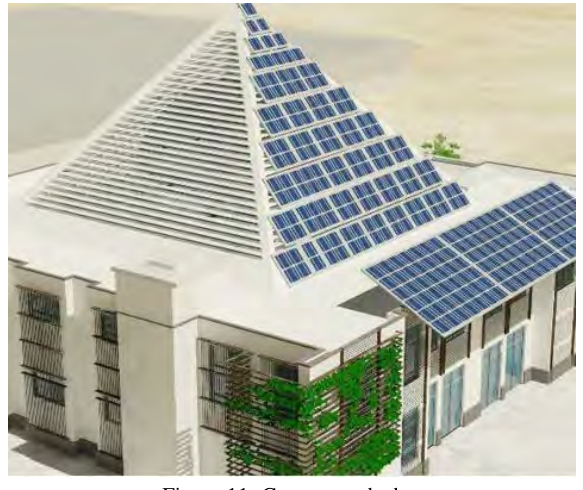
Figure 11. C-west south shot